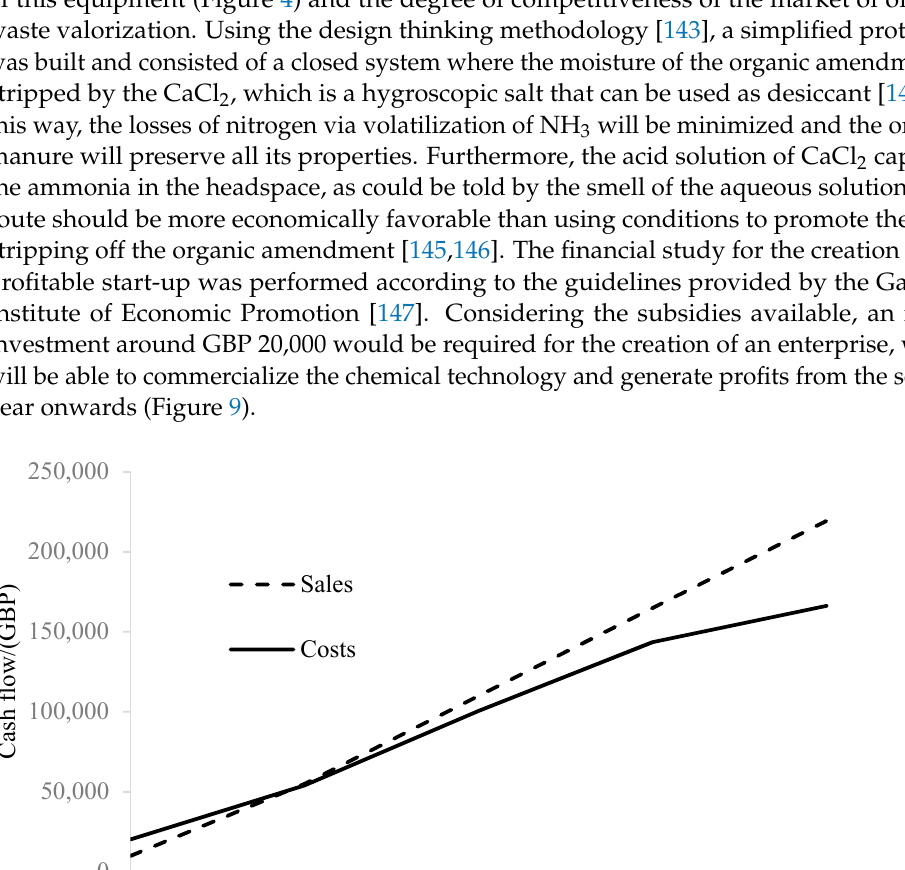
Figure 8. Proposed process B to be implemented directly at the anaerobic digestion plant of one of the stakeholders of the OWAS project.